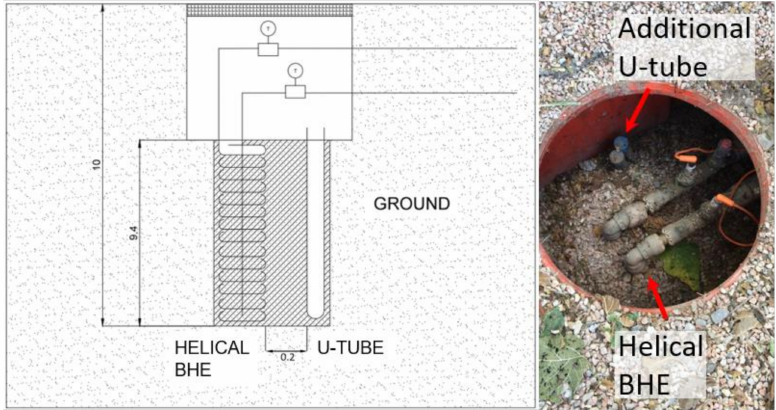
Figure 1. On the left is a schematic of the helical borehole heat exchanger (BHE) installed at the UVP test site, showing the overall and the effective borehole depth (in m) and the additional single-U probe without connection to the system. On the right side is the top of this